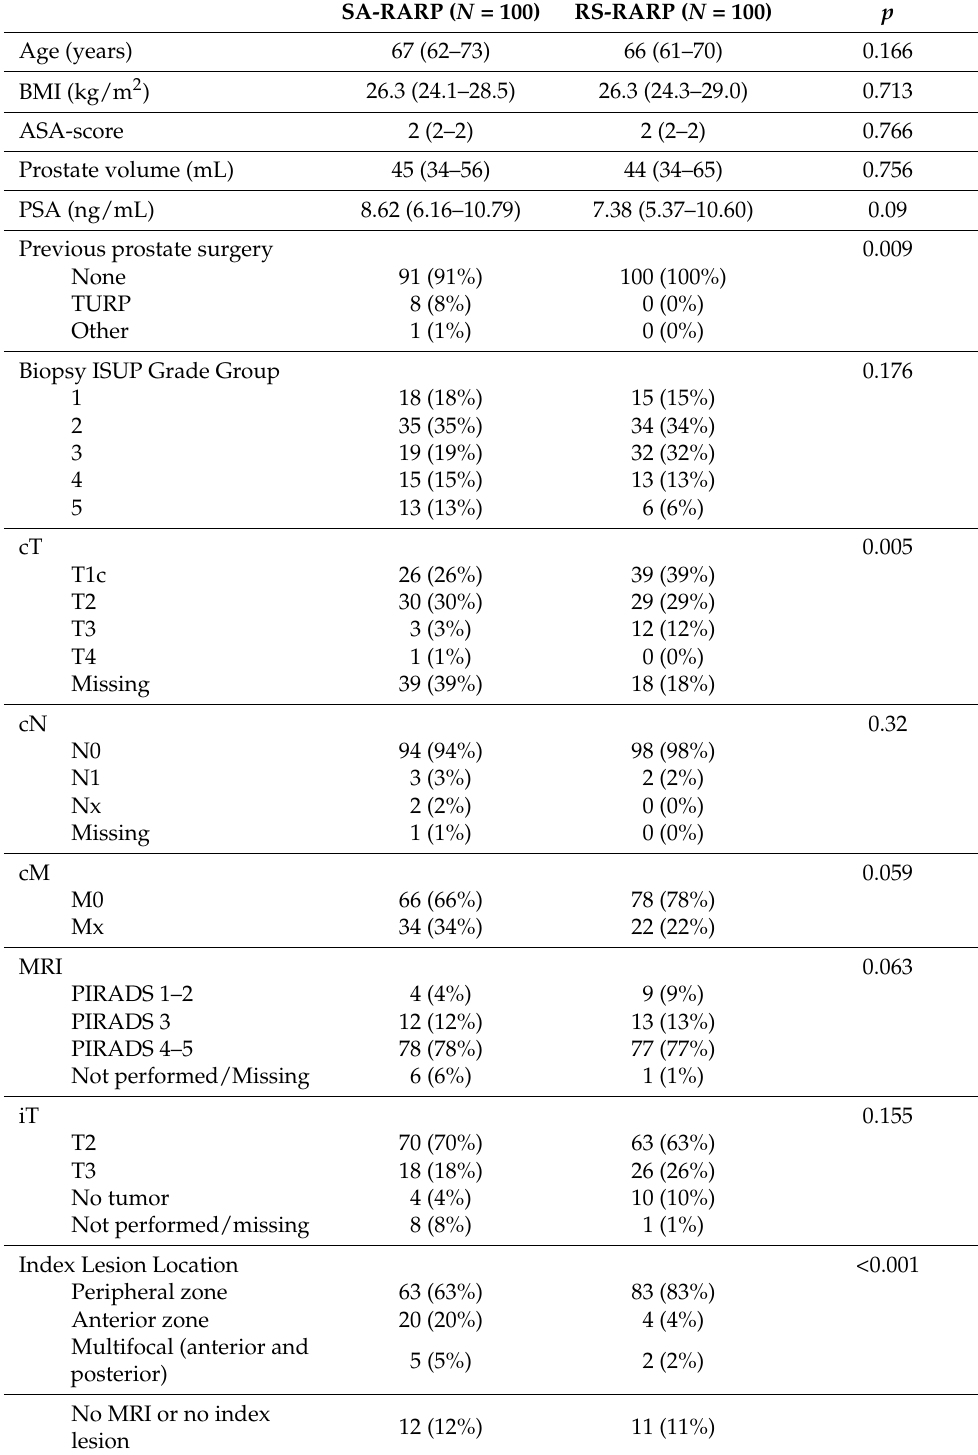
Table 1. Patient and tumor characteristics in the SA-RARP and RS-RARP groups (reported as N (%) and median (interquartile